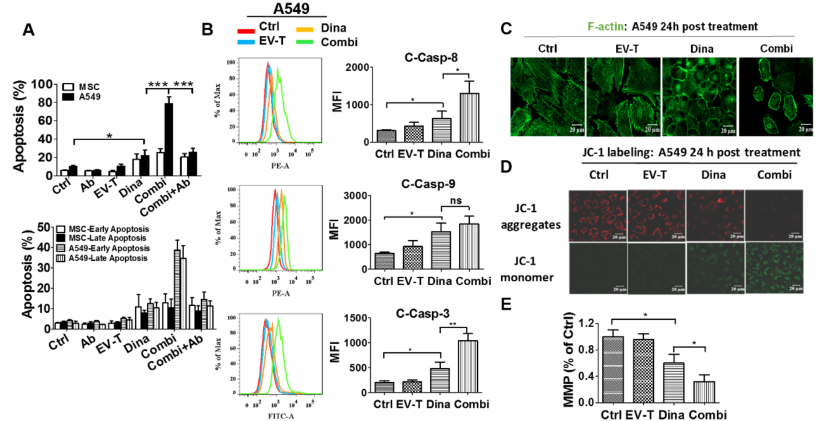
Figure 5. EV-T synergizes with dinaciclib to induce strikingly augmented apoptosis in A549 cells. ( A ) Apoptosis assessment by AF488-Annexin V / PI staining assay for A549 and MSC cells treated by saline (Ctrl), 100 ng / mL TRAIL-neutralizing monoclonal antibody (Ab) (T3067, Sigma-Aldrich), EV-T at 1.0 ng / mL (EV-T) or / and dinaciclib at 15 nM (Dina) (Combi), and Combi plus Ab (Combi + Ab) for 24 h, respectively; ( B ) Comparison of expression levels of activated caspase-8 (C-Casp-8), -9 (C-Casp-9), and -3 (C-Casp-3) by their related PE-, or FITC-conjugated inhibitor labelling combined with flow cytometry analysis in A549 cells that were treated like in A. ( C ) Confocal fluorescent microscopic observation of actin cytoskeleton in A549 cells treated like in A, followed by FITC-phalloidin staining to show F-actin (green). The disruption of actin cytoskeleton in either dinaciclib or combination treatment cells indicates apoptosis occurrence [21]. ( D ). Detection of mitochondrial membrane potential (MMP or ∆ ψ m) change in A549 cells. Cells were treated like in A for 24 h, followed by JC-1 probe labeling and confocal fluorescent microscopic imaging. The loss of ∆ ψ m was indicated by the decrease of JC-1 aggregate abundance (red fluorescence) and the consequent increase of JC-1 monomer abundance (green fluorescence). ( E ) The fluorescence intensity ratio of JC-1 aggregates to monomers was calculated as an indicator of the mitochondrial membrane potential (MMP). MMP is shown relative to control (Ctrl), the value for which was set to 1. All values are mean ± S.E.M ( n = 3). ns, not significant, * p < 0.05, ** p < 0.01, *** p < 0.001 versus Ctrl or Dina, analyzed by Students’ T